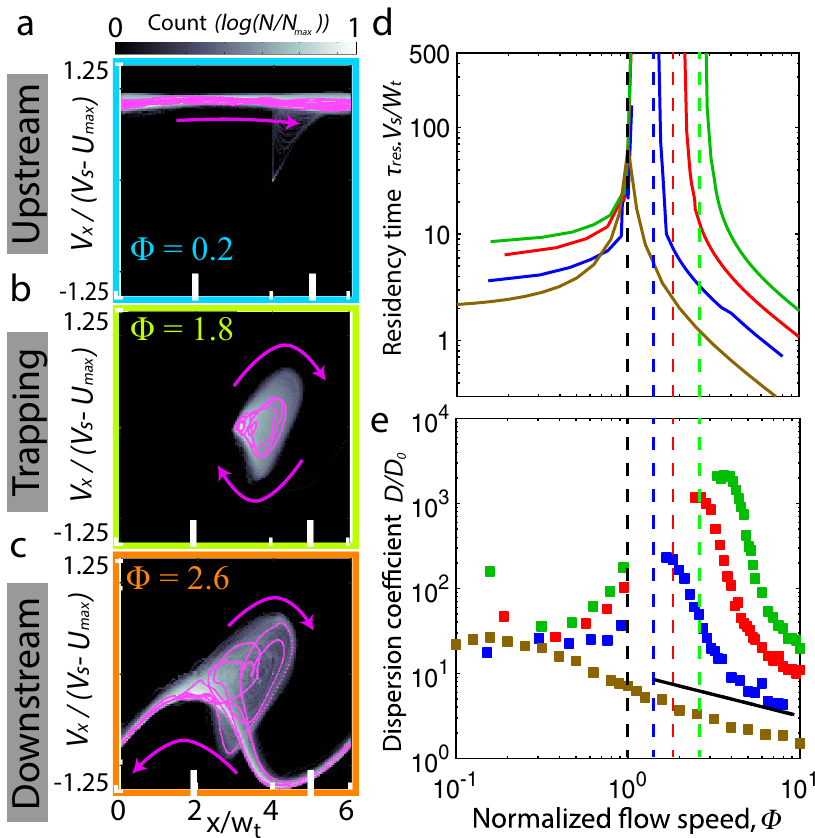
Fig. 3 Vortical trapping enhances retention and increases dispersion. a − c Phase density of cell trajectories from simulations ( w p / w t = 5; see also Supplementary Fig. 5) for three observed transport regimes: upstream ( a , Φ = 0.2), trapping ( b , Φ = 1.8), and downstream ( c , Φ = 2.6). A magenta curve is a single, sample cell trajectory with arrows indicating direction. Color map shows the normalized cell count (log-scale) for 100 cells over a simulated time t = 500 w t / V s . d Normalized residency time in a pore as a function of normalized fl ow speed Φ determined from Langevin simulations for w p / w t = 3 (blue), 5 (red), and 7 (green). Brown line corresponds to a straight duct (width, w = w t ). Vertical black and colored dashed lines correspond to Φ = 1 and Φ * in Fig. 2b, c. e Normalized stream-wise dispersion coef fi cients, D / D 0 , as a function of normalized fl ow speed determined from Langevin simulations for w p / w = 3 (blue), 5 (red), and 7 (green) and through a straight duct (brown). All dispersion coef fi cients are normalized by D t ( Φ = 0). The solid black line indicates slope −